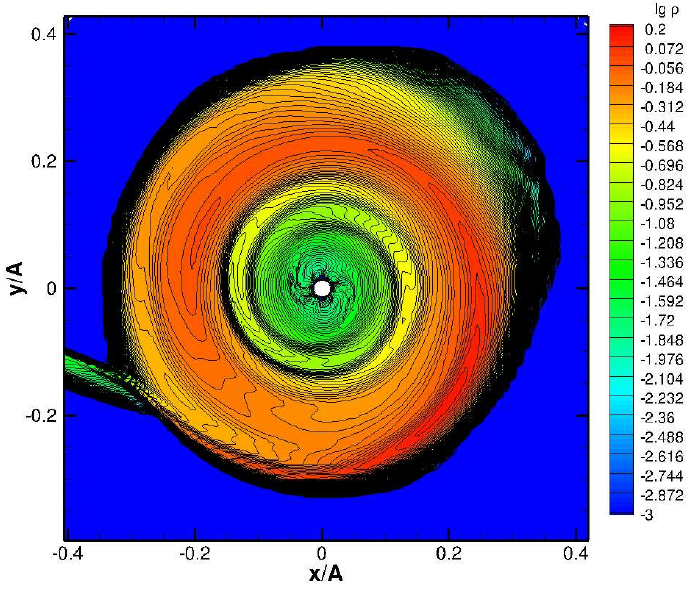
Figure 2. Two-dimensional structure of the flow in the area of accretion disk for the intermediate polar EX Hya. The decimal logarithm of the density distribution in units of ρ ( L 1 ) in the equatorial plane ( xy ) of the binary system are